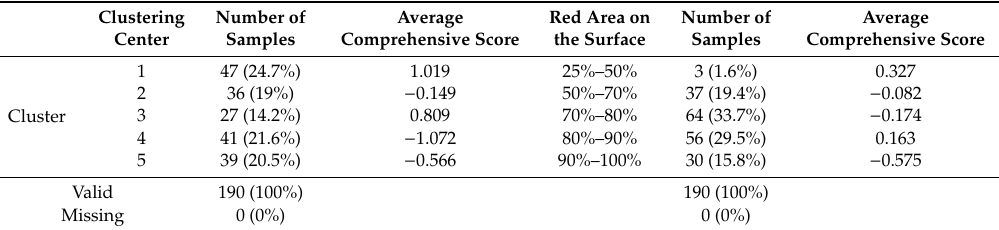
Table 5. Comparison of grading